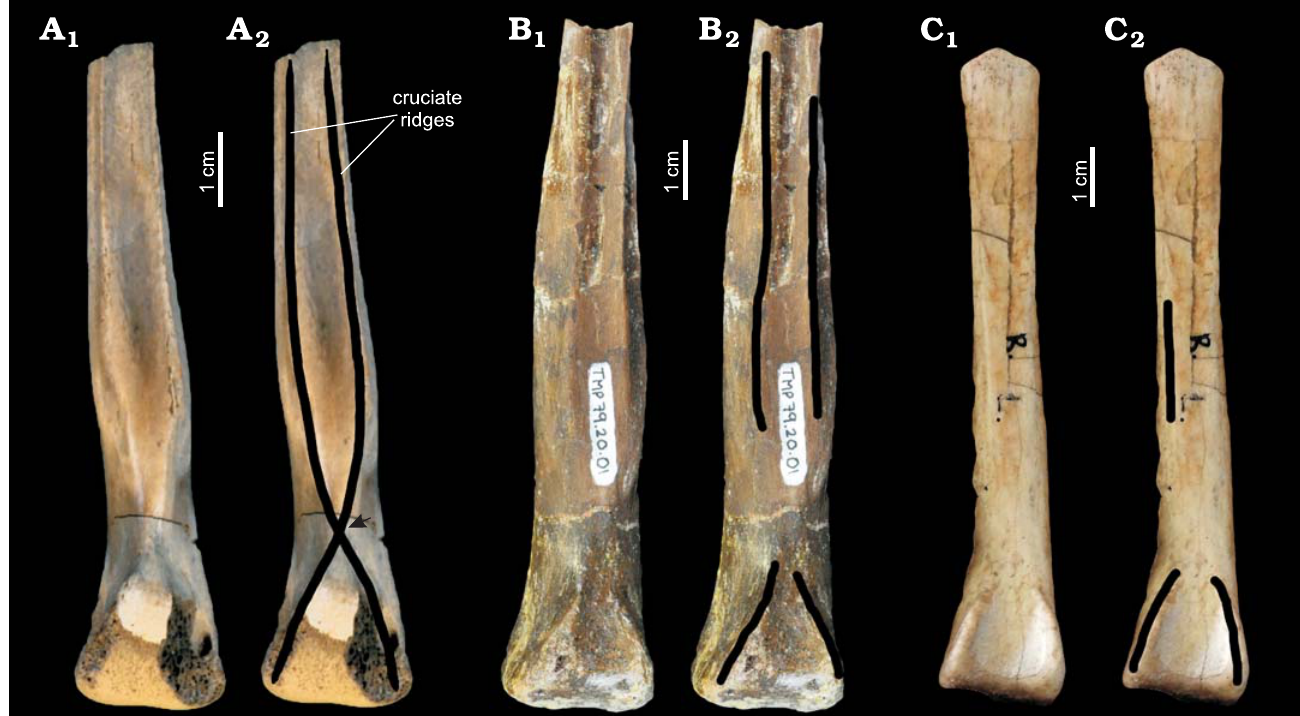
Fig. 4. Posterior surface of metatarsal III in elmisaurine dinosaurs. A . Leptorhynchos elegans (Parks, 1933) (TMP 1986.036.0186) from Upper